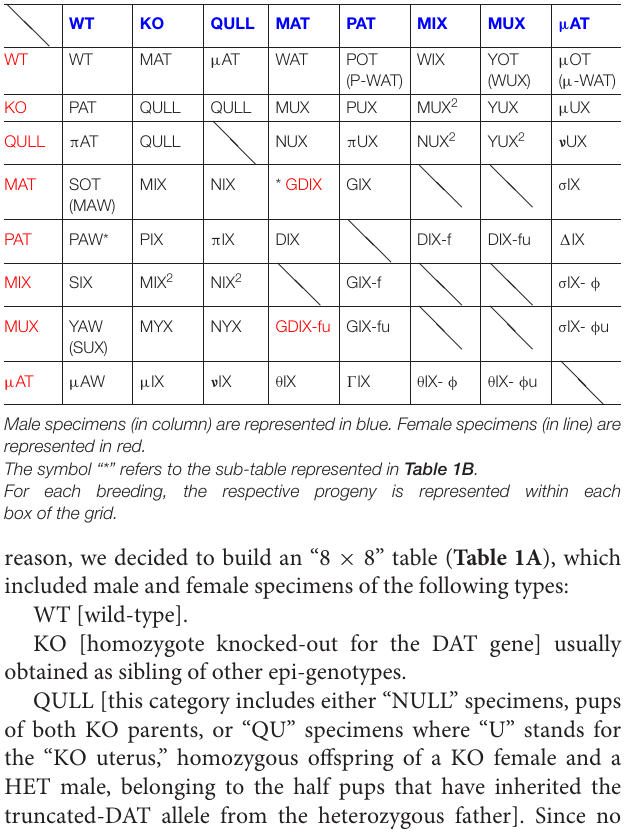
TABLE 1A | Epigenetic acronyms for the progeny.